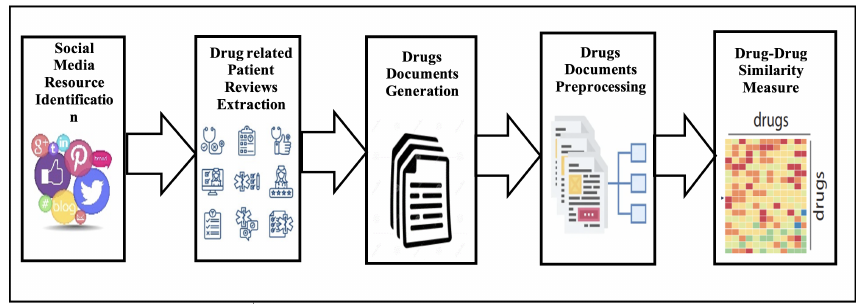
Figure 1. Drug–Drug similarity computation from social